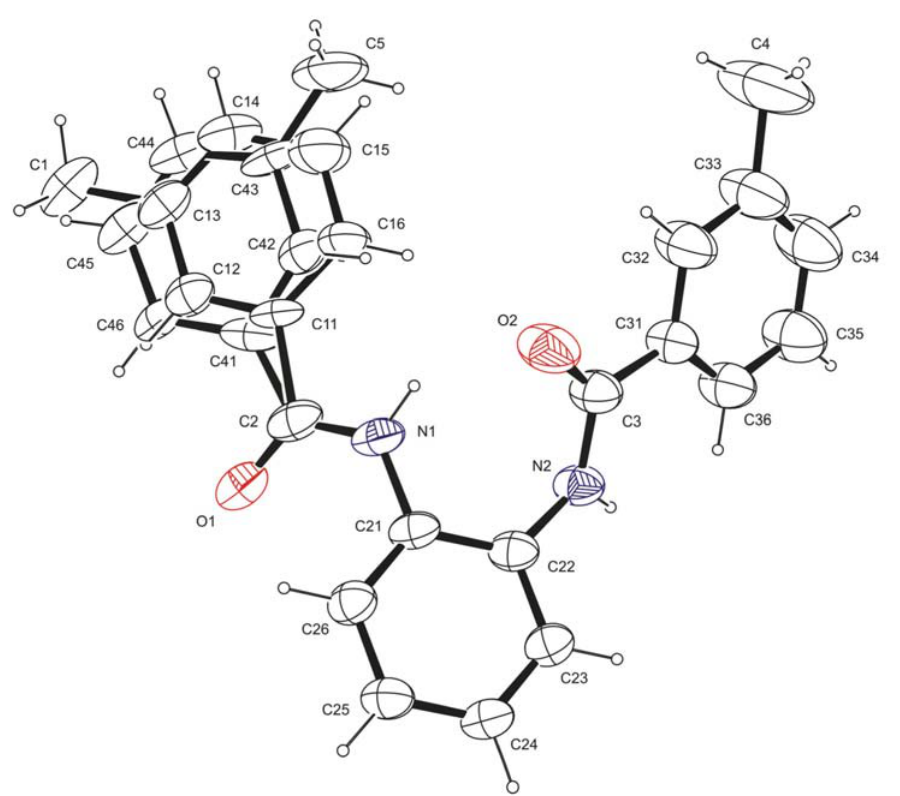
Figure 2. An ORTEP view of compound I showing 50% probability displacement ellipsoids and the atom